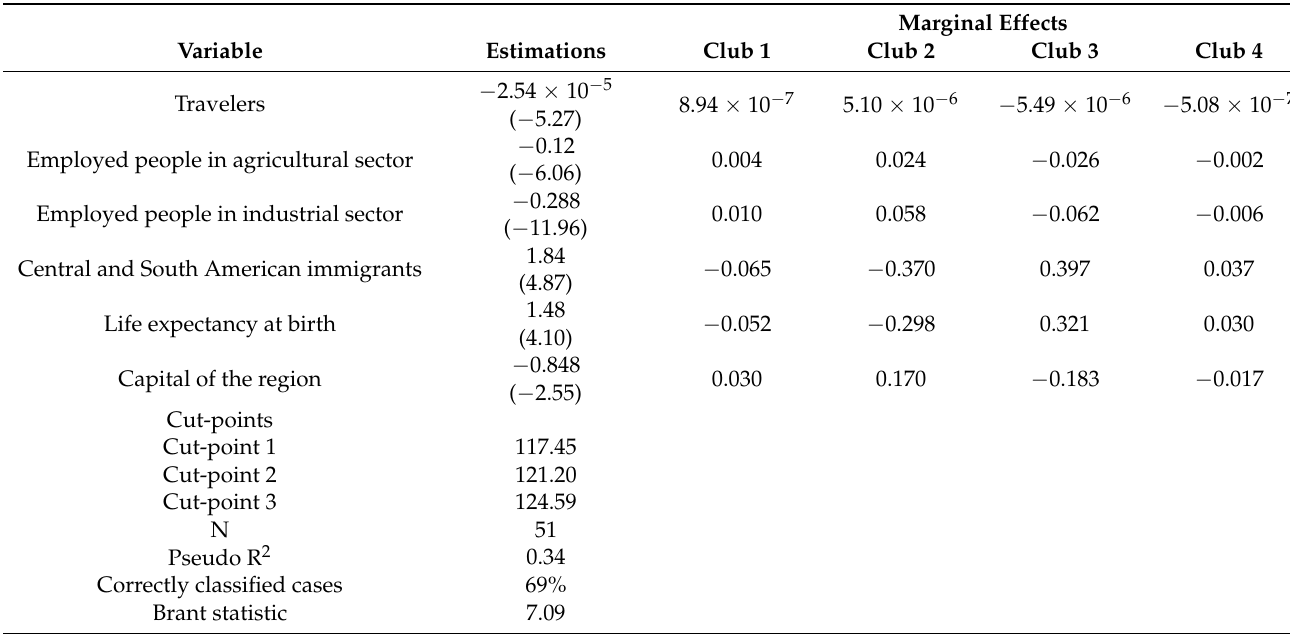
Table 3. Factors driving the